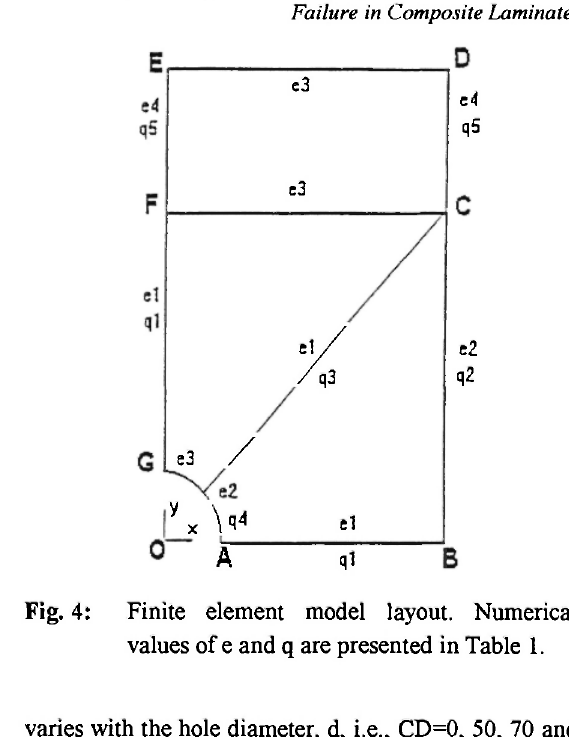
varies with the hole diameter, d, i.e., CD=0, 50, 70 and 92 mm for d=4, 8, 15 and 25 mm, respectively. The magnitude of CD varied because small values of CD combined with large hole diameters would result in bending of the FC line towards the hole and hence would affect the stress results. The number of elements used along the AB, BC, etc., boundaries is shown in Table 1. The kinematic boundary conditions are: dis- placement u=0 along the EG line and displacement v=0 along the AB line. A uniformly distributed load parallel to y-axis is applied along the ED boundary.